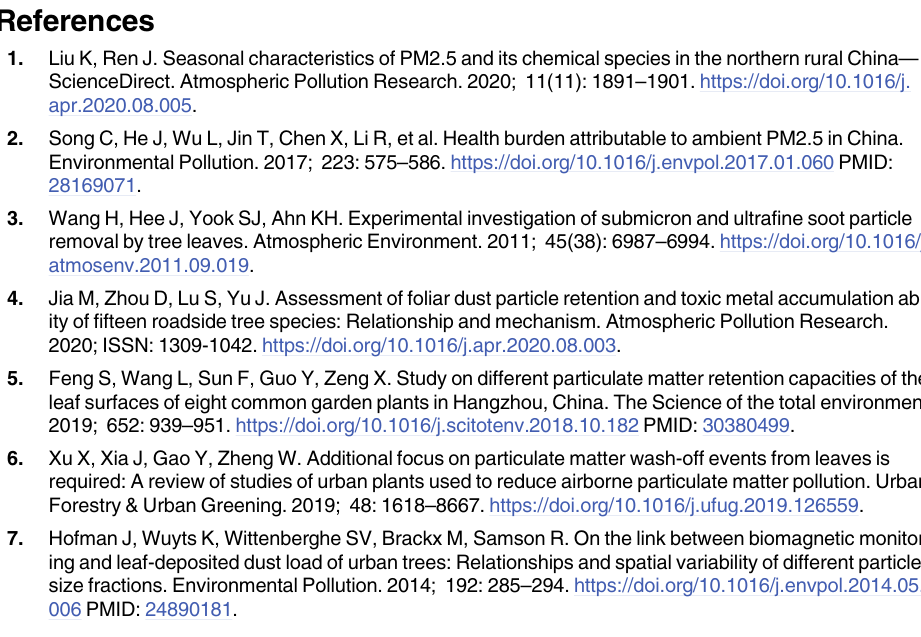
S1 Table. Clones